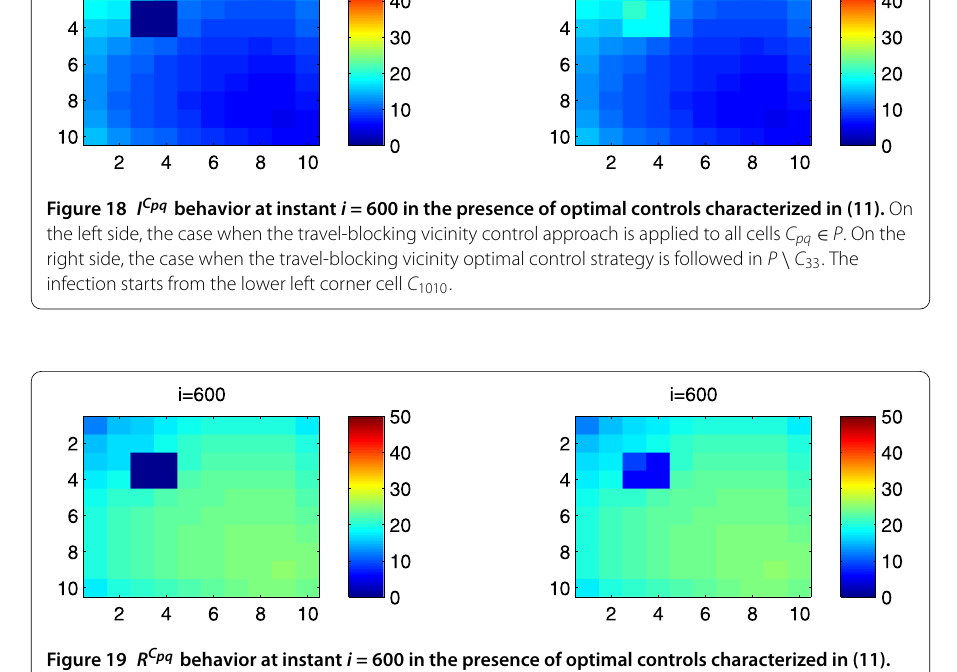
Figure 19 R Cpq behavior at instant i = 600 in the presence of optimal controls characterized in (11). On the left side, the case when the travel-blocking vicinity control approach is applied to all cells C pq ∈ P . On the right side, the case when the travel-blocking vicinity optimal control strategy followed in P \ C 33 . The infection starts from the lower left corner cell C 1010